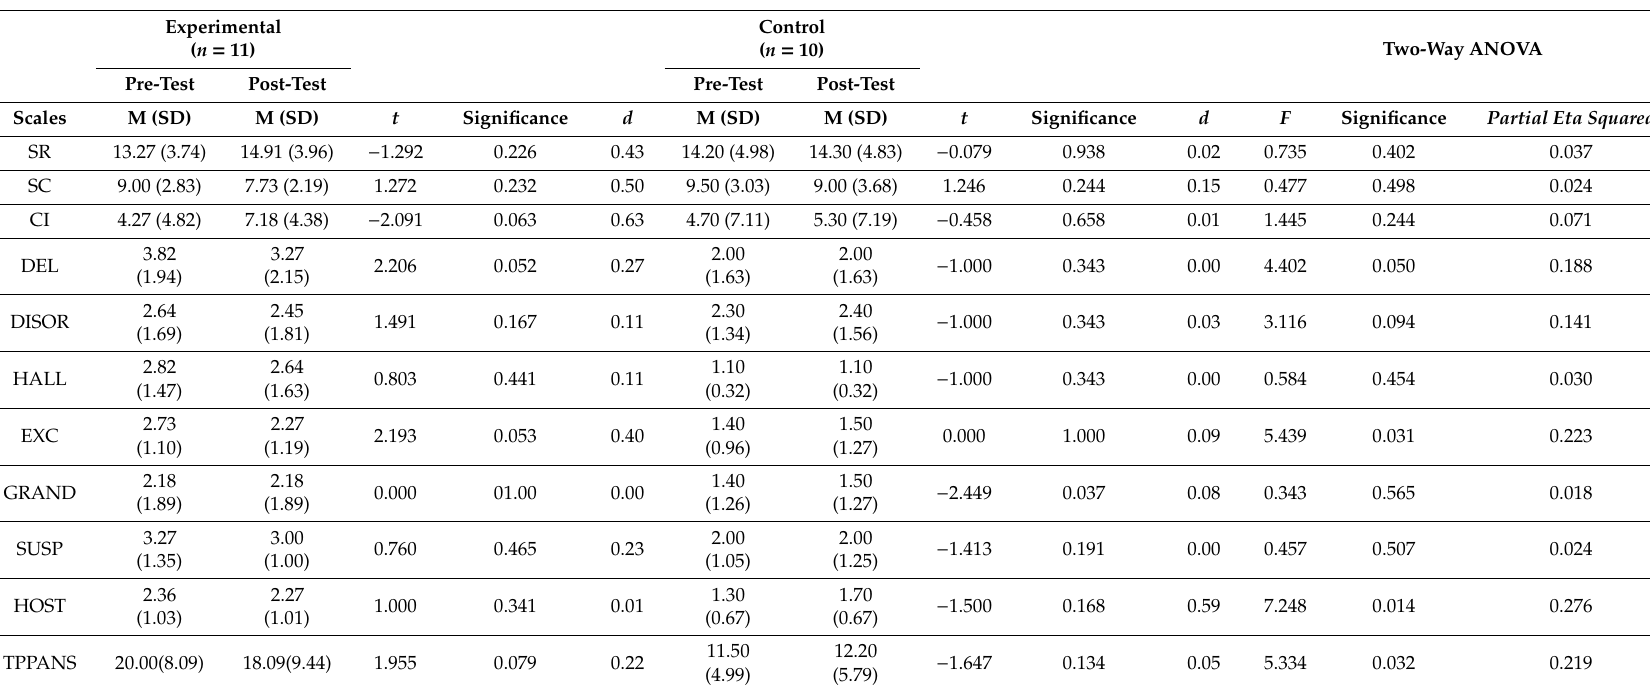
Control ( n = 10) Two-Way ANOVA